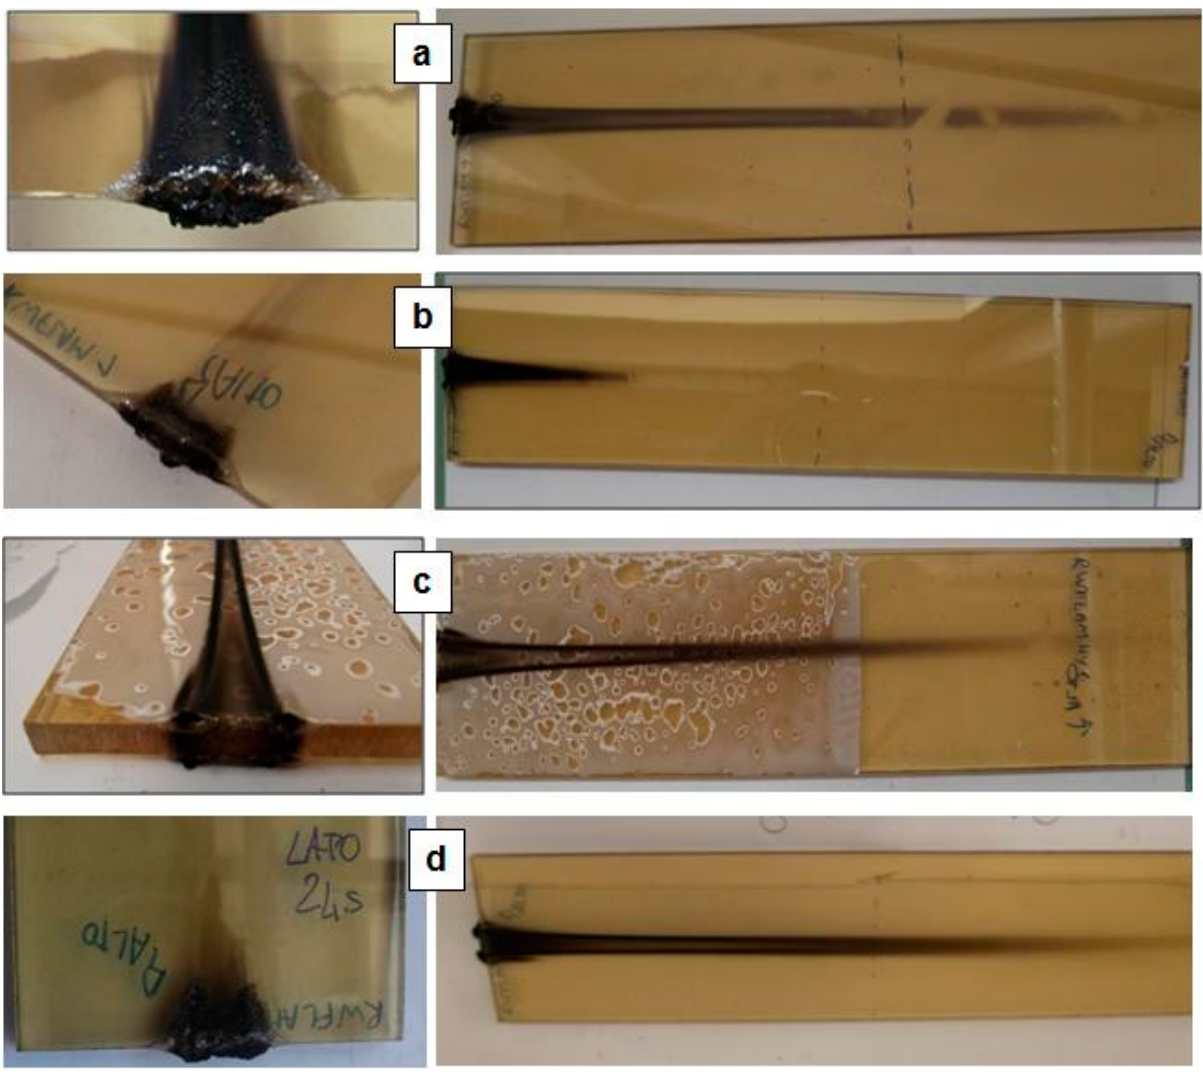
Figure 3. Flammability test: pictures of specimen charred area (left) and damaged surface (right) from ( a ) R, ( b ) R-2L, ( c ) R-HY and ( d ) R-2T testing series.